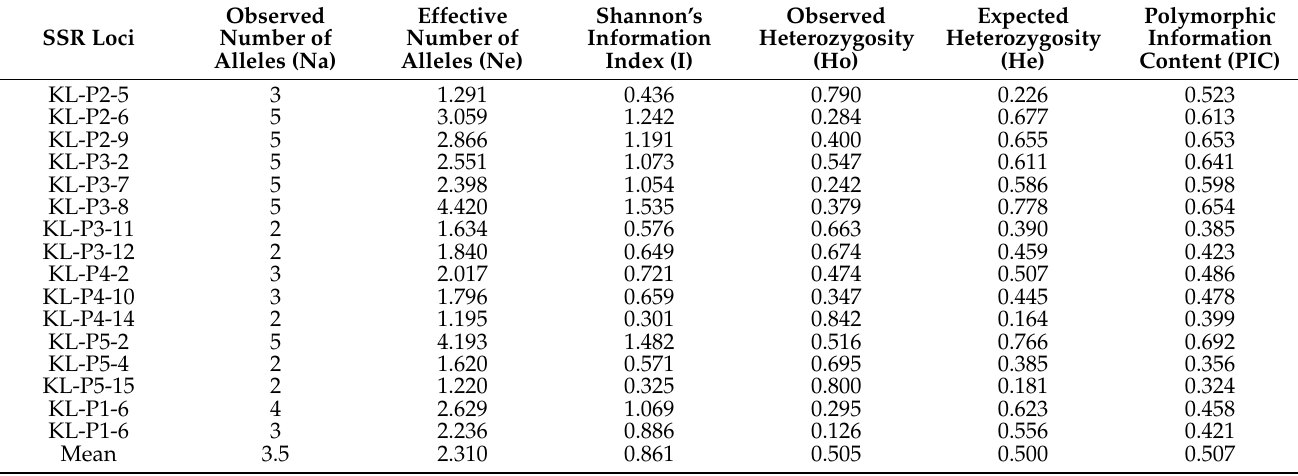
Table 2. Genetic parameters of 16 polymorphic